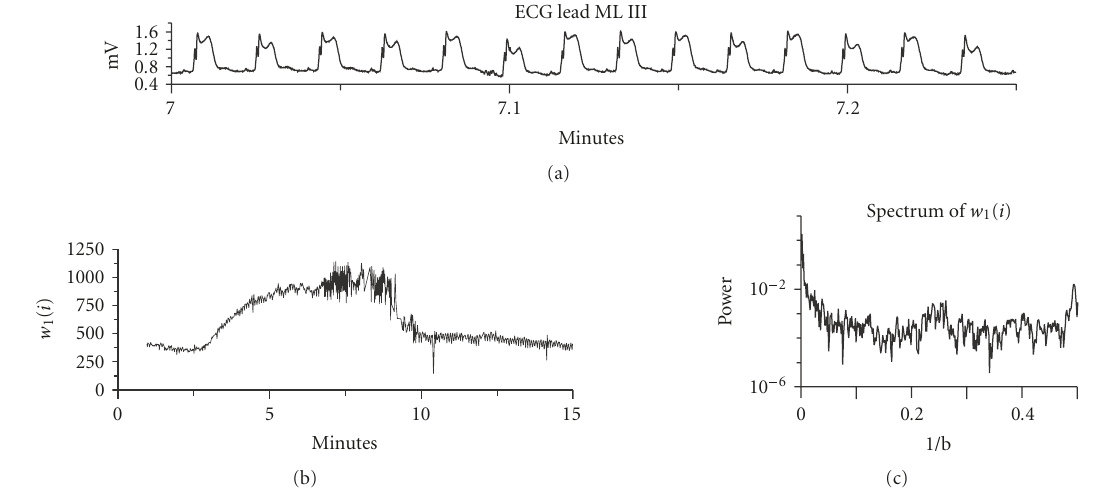
Figure 10: (a) An ECG signal with pronounced T wave alternans during the acute phase of ischemia which has resulted in pronounced ST elevation. (b) The corresponding principal component series w 1 ( i ), and (c) the beatquency spectrum. Note the marked peak at 0.5 cycles by beat (1/b) which reflects the alternans